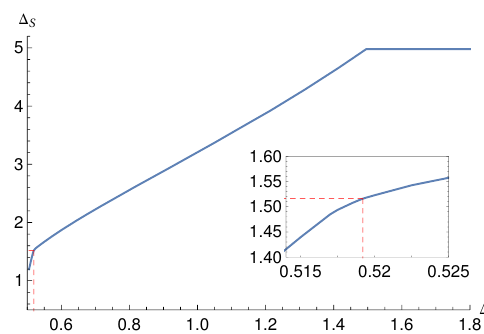
Figure 5 . Bound on the dimension of the first neutral parity-even scalar operator as a function of ∆ φ . For ∆ φ . 1 . 5 the bound is driven by the scalar bound. The plateau for larger values of ∆ φ corresponds to the bound from the current bootstrap. The bound displays a kink corresponding to the O (2) model. The bounds have been obtained at Λ = 13